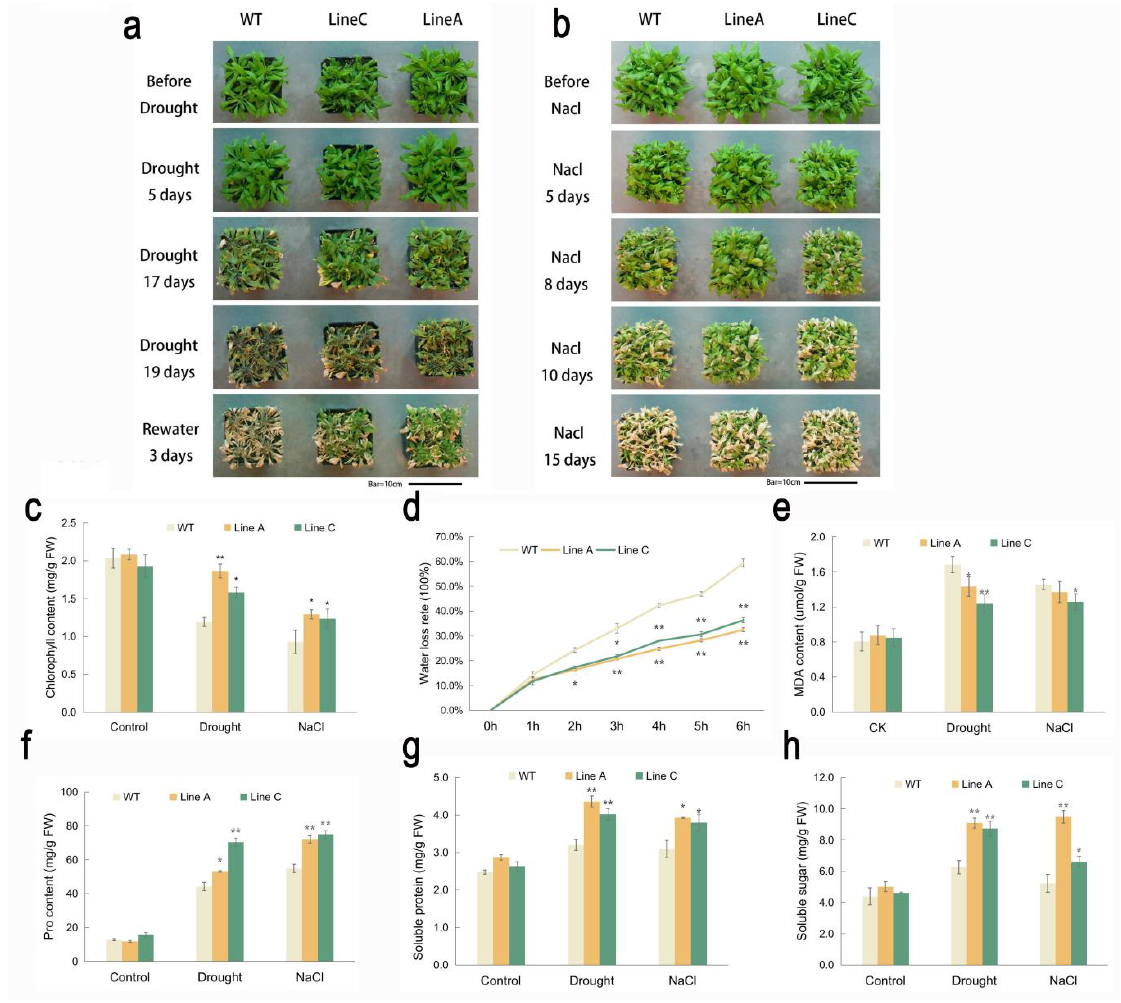
Figure 4. Analysis of drought and salinity tolerance at the adult stage. ( a , b ) showed the change of growth status of transgenic and WT plants during the progress of drought and salinity treatments. ( c – h ) showed measurements of tolerance-related physiological indexes. Data are presented as mean and SD values of three independent experiments. Asterisks indicated significant difference (* p < 0.05, ** p < 0.01, by independent sample t -test) comparing to WT.